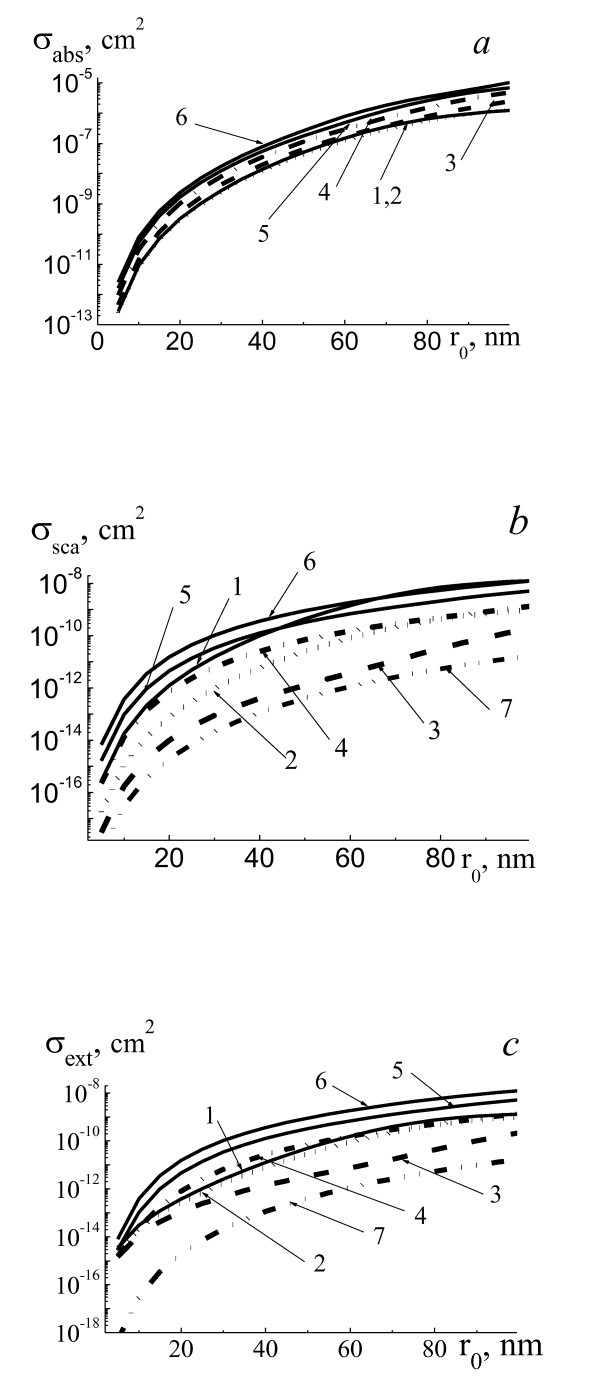
Efficiency cross sections σabs (a), σsca (b), and σext (c) of laser radiation. With wavelength 780 nm by two-layered spherical system gold NP core and water vapor shell with refractive index of vapor m1 = 1.001-i0 placed in water for the range of NP radii r0 = 5 to 100 nm and radii of system r1 = r0 (1, pure gold NP, straight line), r1 = r0 + 0.1r0 (2, dotted line), r1 = r0 + 1r0 (3, dashed line), r1 = r0 + 2r0 (4, dashed-dotted line), r1 = r0 + 3r0 (5, straight line), and r1 = r0 + 4r0 (6, straight line), and for homogeneous vapor bubble with r0 (7, dashed-double dotted line).